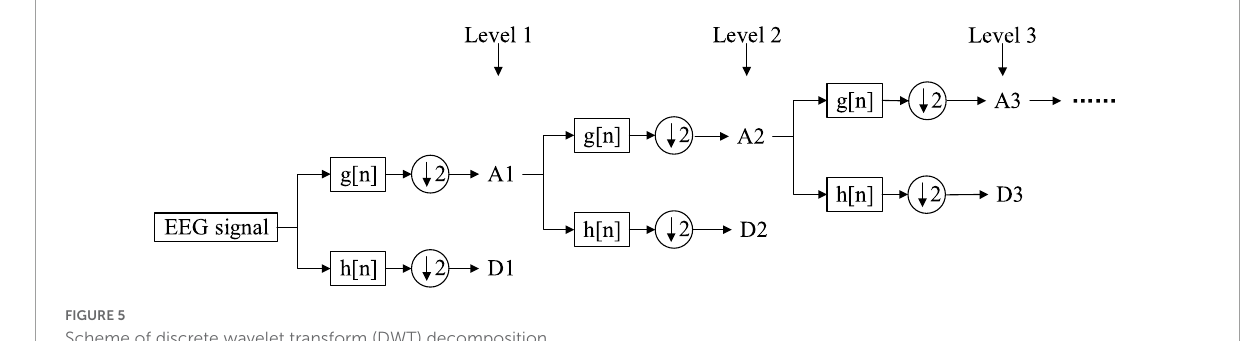
FIGURE5 Scheme of discrete wavelet transform (DWT) decomposition.